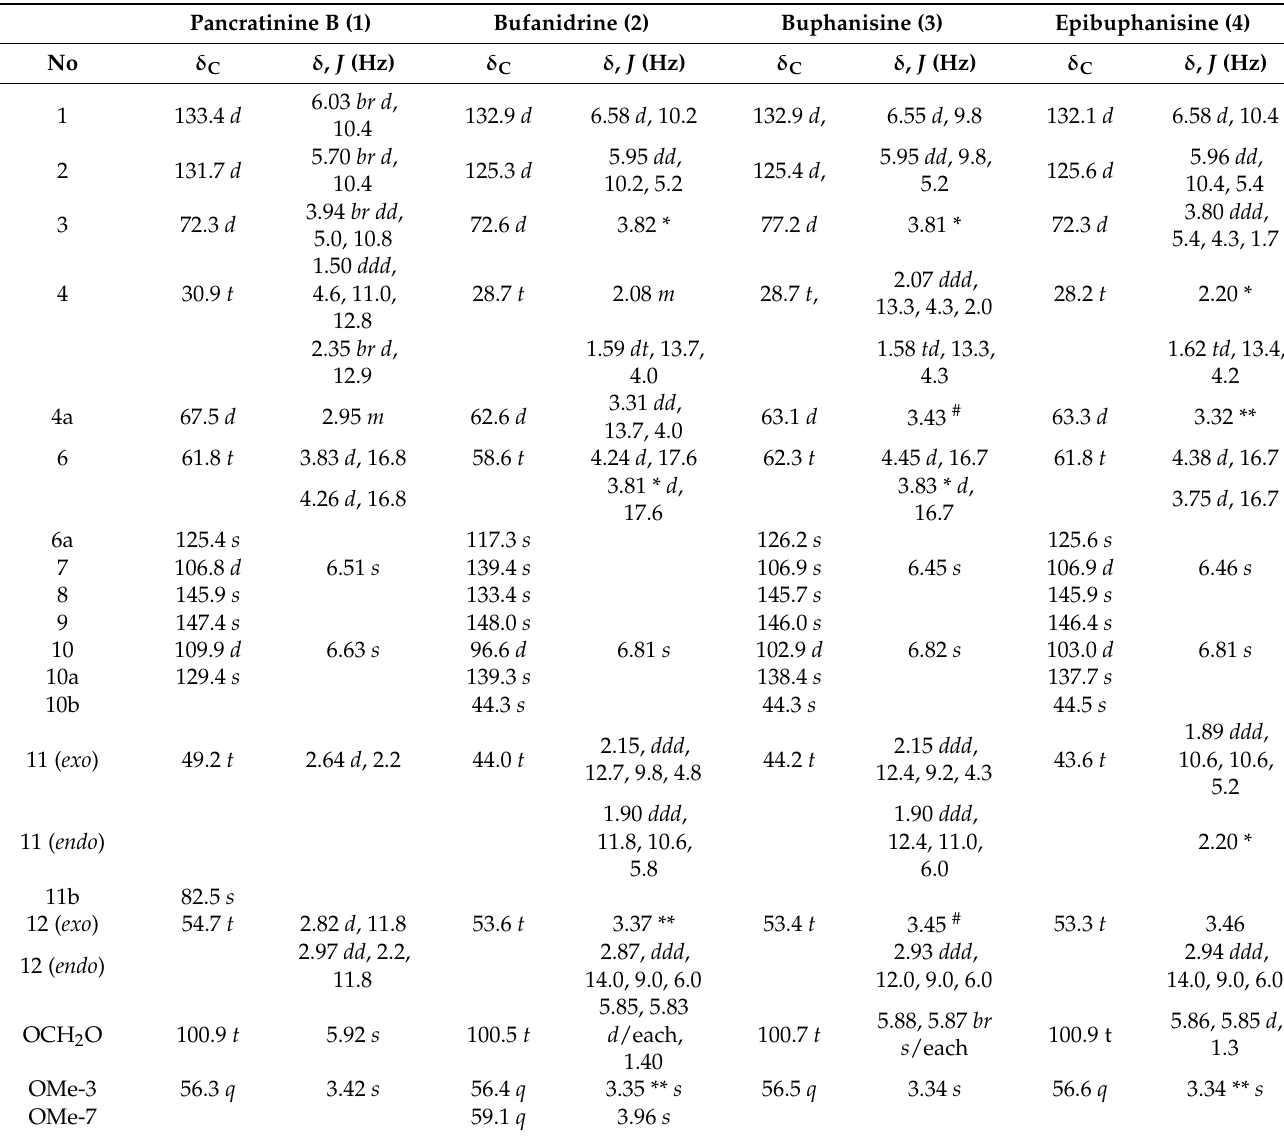
Figure 1. Chemical structures of isolated compounds 1 – 4 from C. flava . Table 1. 1 H (400 MHz) and 13 C (100 MHz) NMR data of compounds 1 – 4 in CDCl 3